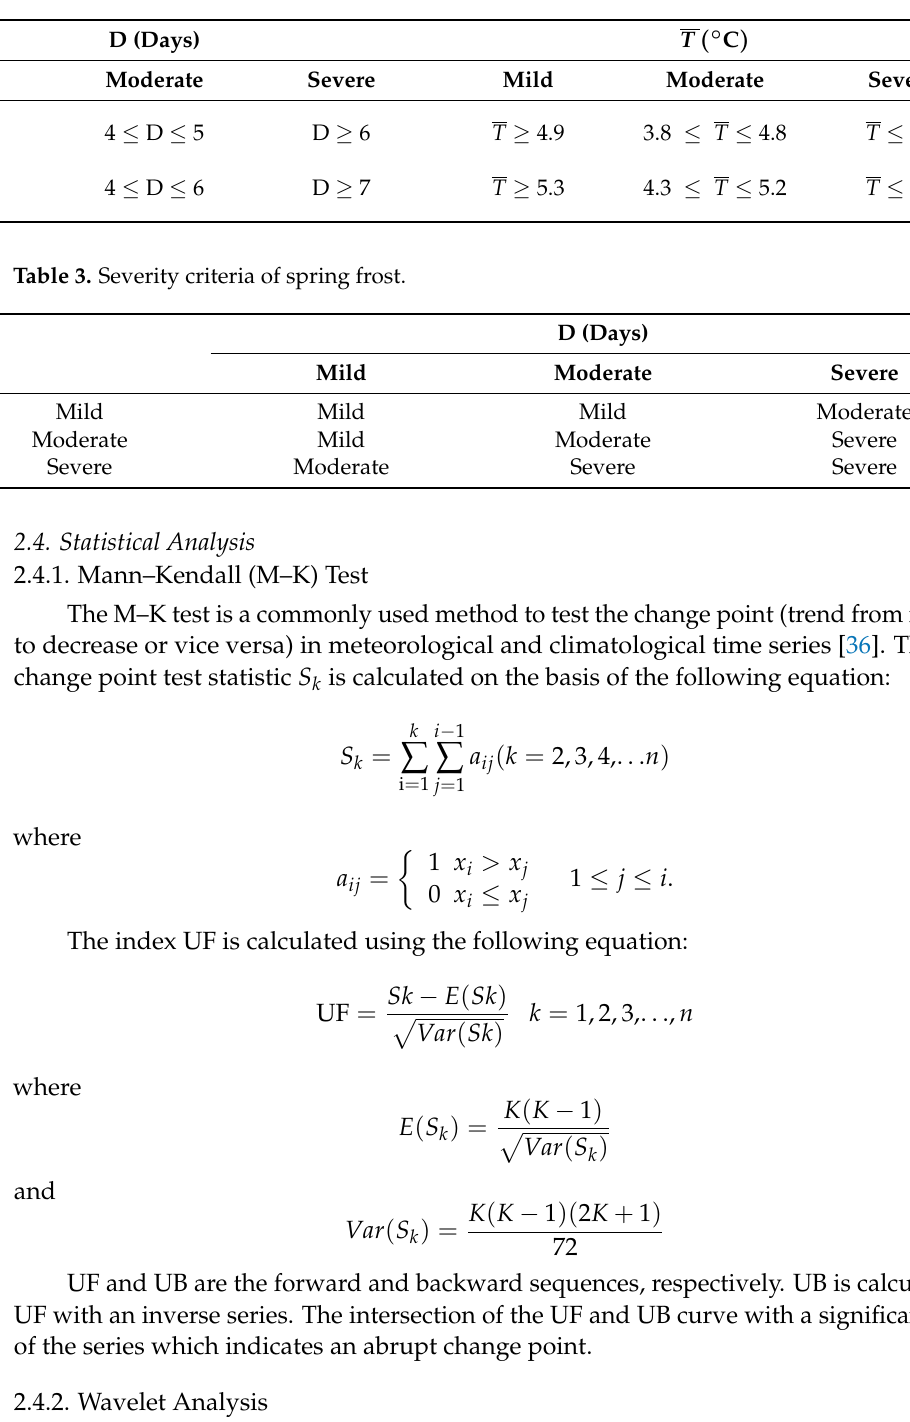
Table 3. Table 2. Different classes of spring frost classified in accordance with the values of D and T .